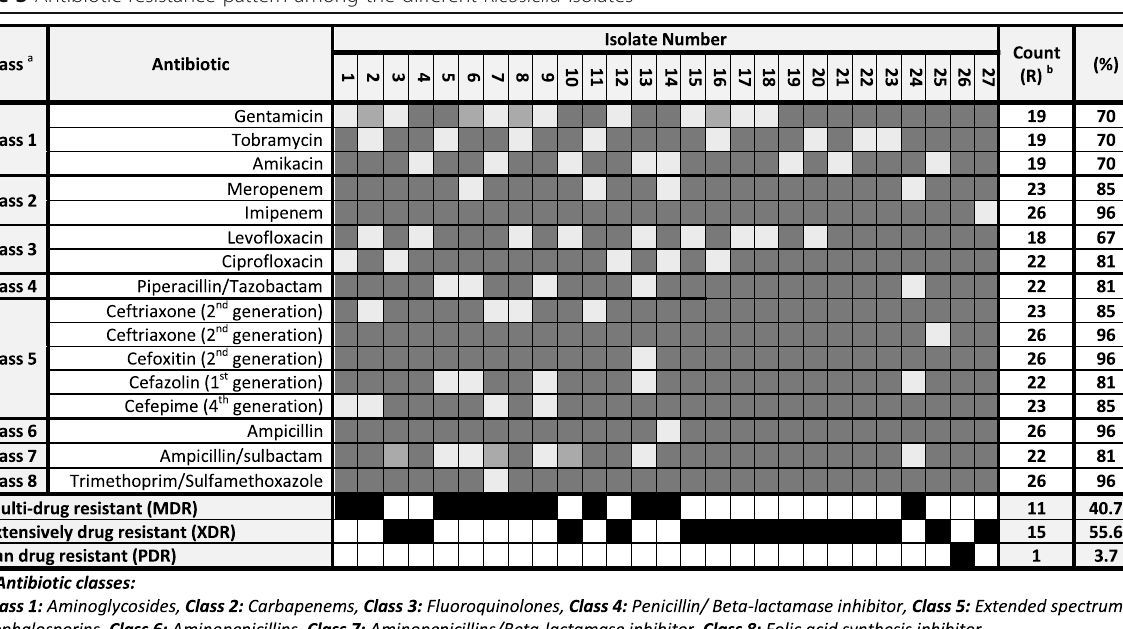
Resistant, dark gray; intermediate, medium gray; sensitive, light gray a Antibiotic classes: class 1, aminoglycosides; class 2, carbapenems; class 3, fluoroquinolones; class 4, penicillin/beta-lactamase inhibitor; class 5, extended-spectrum cephalosporins; class 6, aminopenicillins; class 7, aminopenicillins/beta-lactamase inhibitor; and class 8, folic acid synthesis inhibitor b R number of resistant